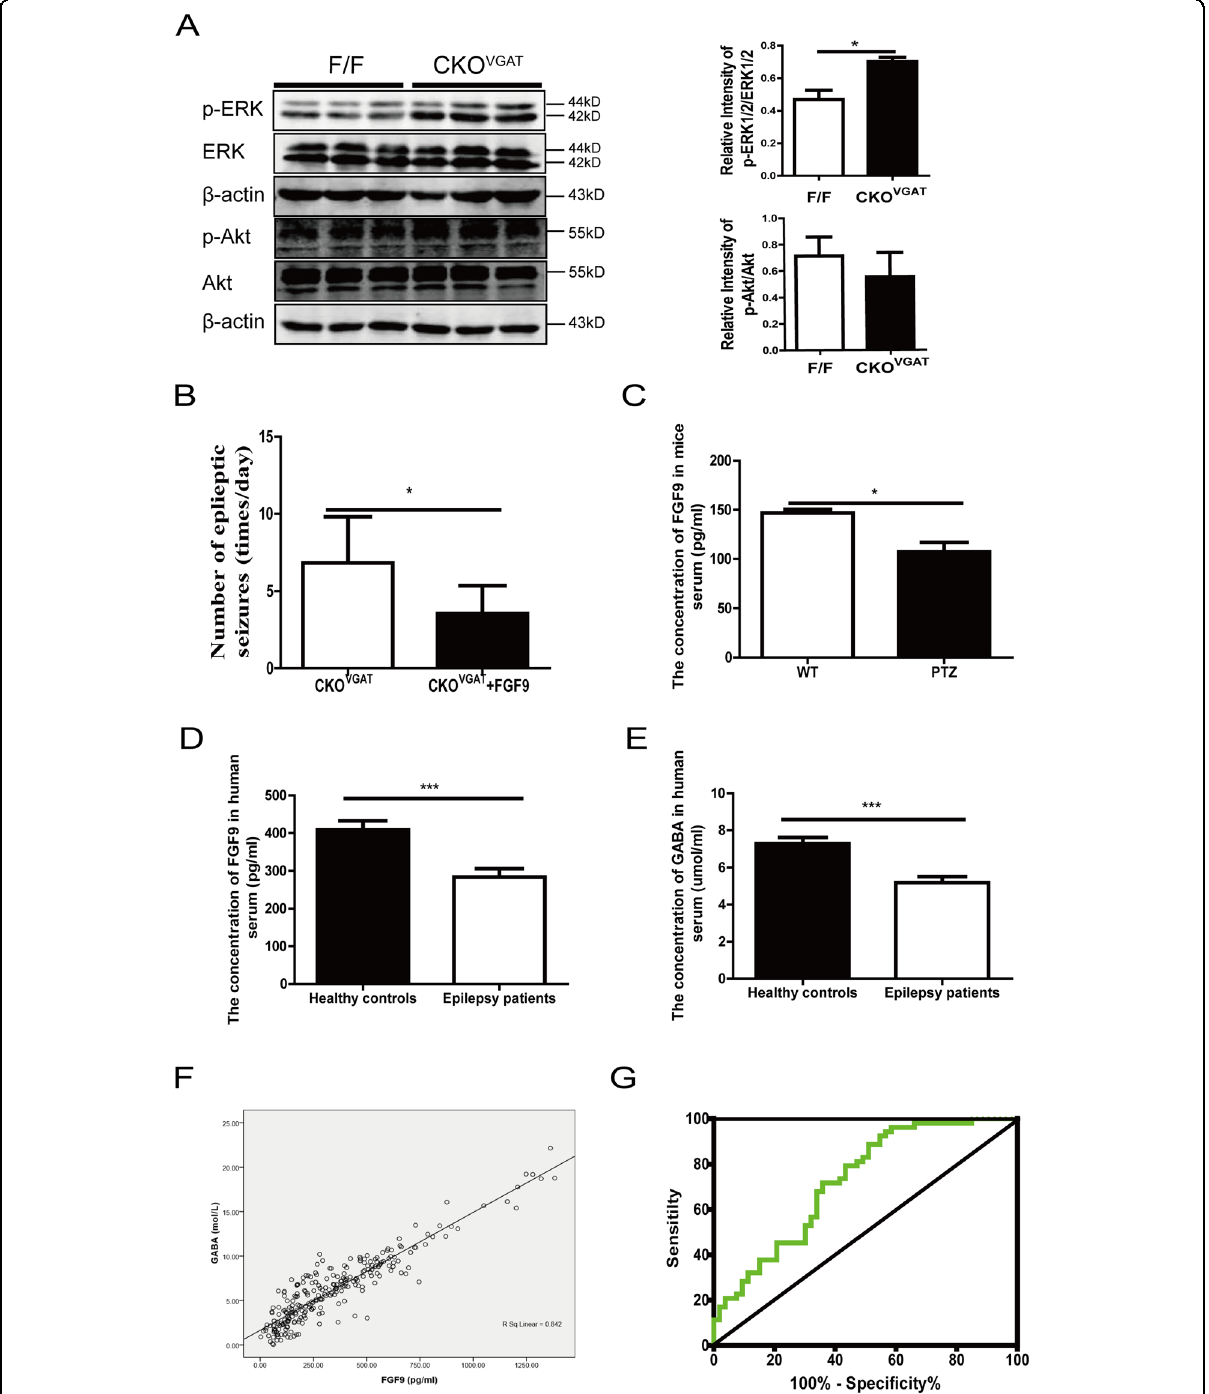
Fig. 6 Decreased expression of FGF9 is a common mechanism in epilepsy. A The ERK1/2 pathway was activated in CKO VGAT mice. Each test was repeated 3 times. β -actin was used as the internal loading control. Data are presented as mean ± SEM; * P < 0.05 and ** P < 0.01. B Administration of rhFGF9 proteoliposomes signi fi cantly reduced the frequency of seizures in CKO VGAT mice ( n = 6). Signi fi cant differences from the control: * P < 0.05, paired Student ’ s t -test. C The expression of FGF9 determined by ELISA was lower in the serum of PTZ-induced mice ( n = 5) that in that of control mice. D , E ELISA to quantify FGF9 and GABA levels in serum from 128 controls and 128 epileptic patients. F The correlation between the serum expression of FGF9 and GABA was signi fi cant ( r 2 = 0.842). G ROC curve analysis showed the diagnostic signi fi cance of FGF9 in patients with focal seizures (AUC =